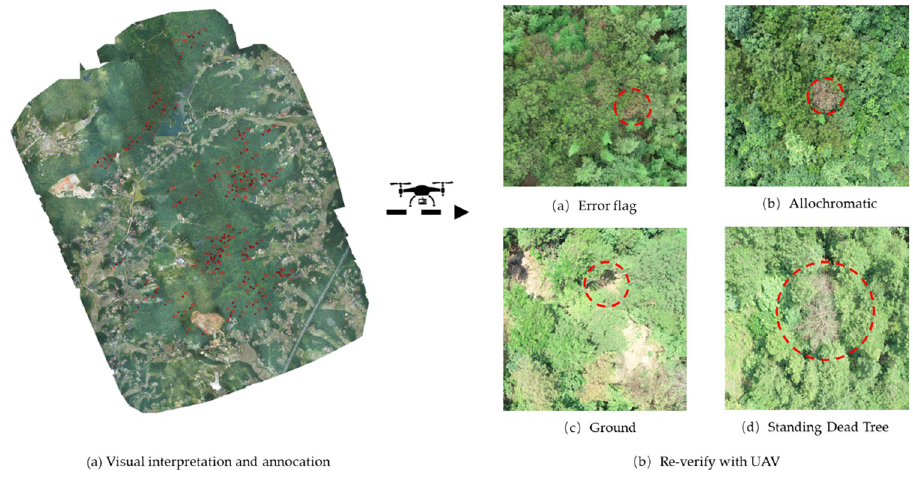
Fig 2. Manually mark suspected points and Re-verify with